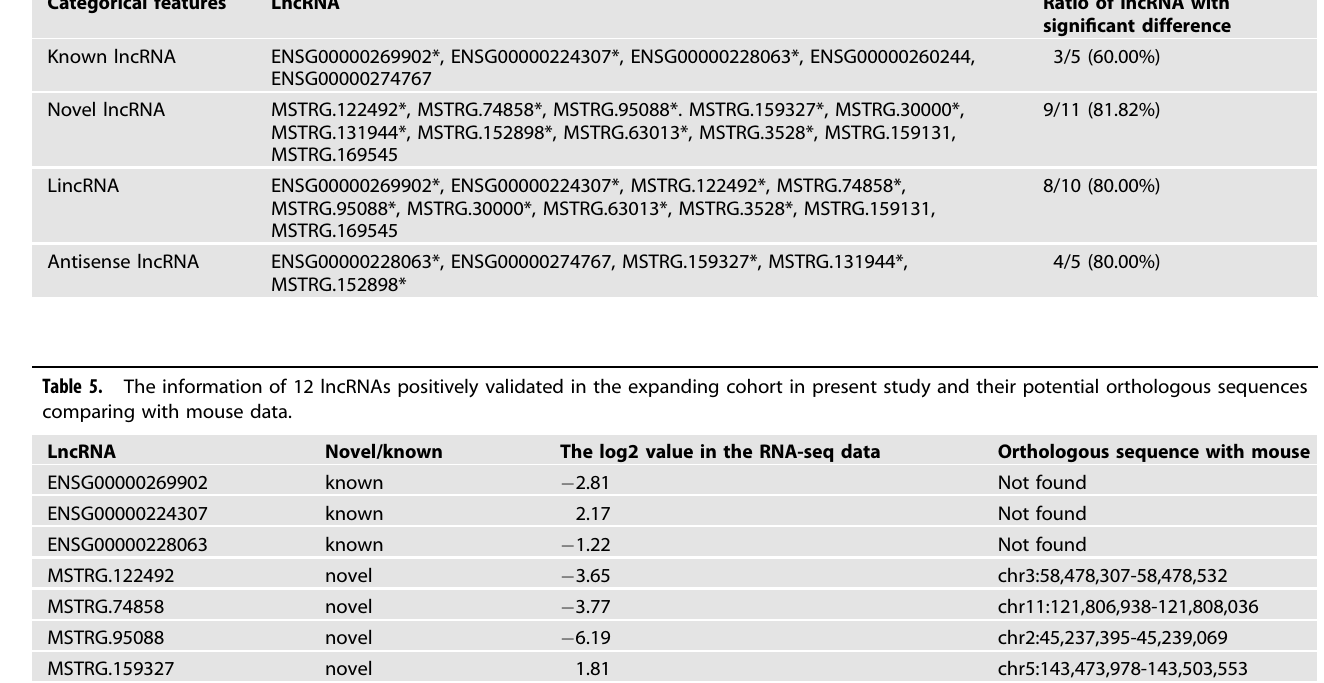
Table 4. The results of analysis by the categorical features of 16 lncRNAs which were chosen in validation cohorts. “ * ” marked the validation positive lncRNA.